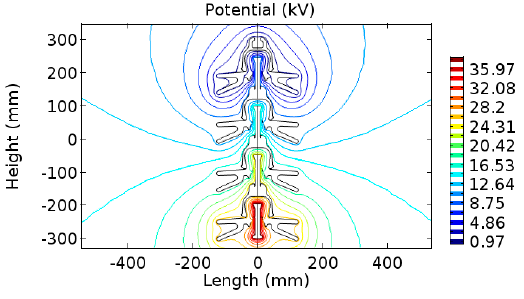
Figure 6. Equipotential line distribution of insulator string under clean and dry conditions.